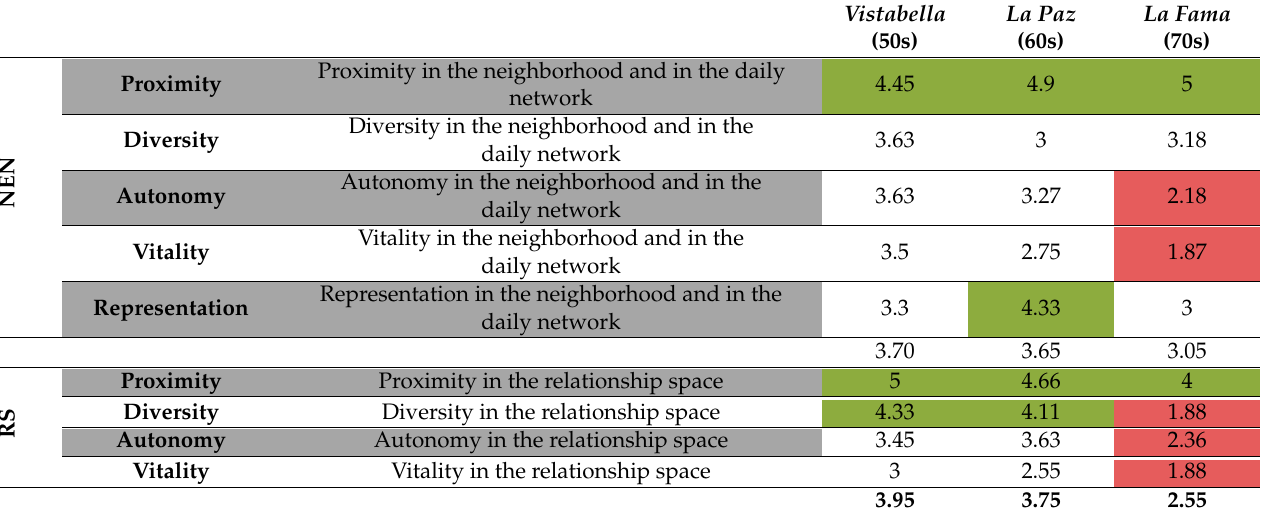
Table 3. Col.Lectiu Punt 6